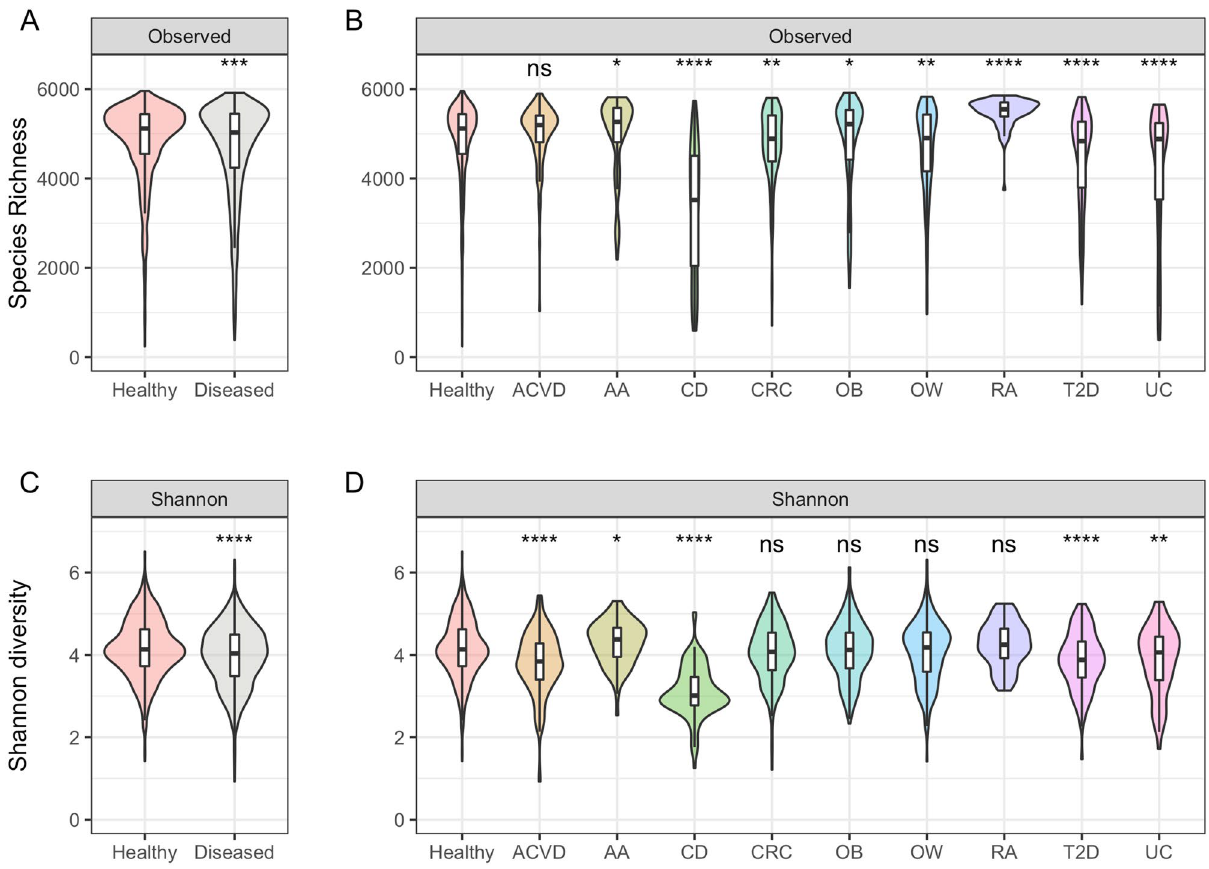
Figure 4. Alpha-diversity comparisons between datasets. ( A ) Species richness plot between healthy and diseased datasets, ( B ) species richness plot comparison between all phenotypes, ( C ) Shannon-diversity plot between healthy and diseased datasets, and ( D ) Shannon-diversity plot between all phenotypes. Two-sided Mann–Whitney U test was used to compare respective disease datasets against the healthy dataset. The p-value significance are shown above violin plots: ns (non-significant; p-value > 0.05 ), *(p-value < 0.05 ), **(p-value < 0.01 ), ***(p-value < 1 e − 3 ), ****(p-value < 1 e − 4